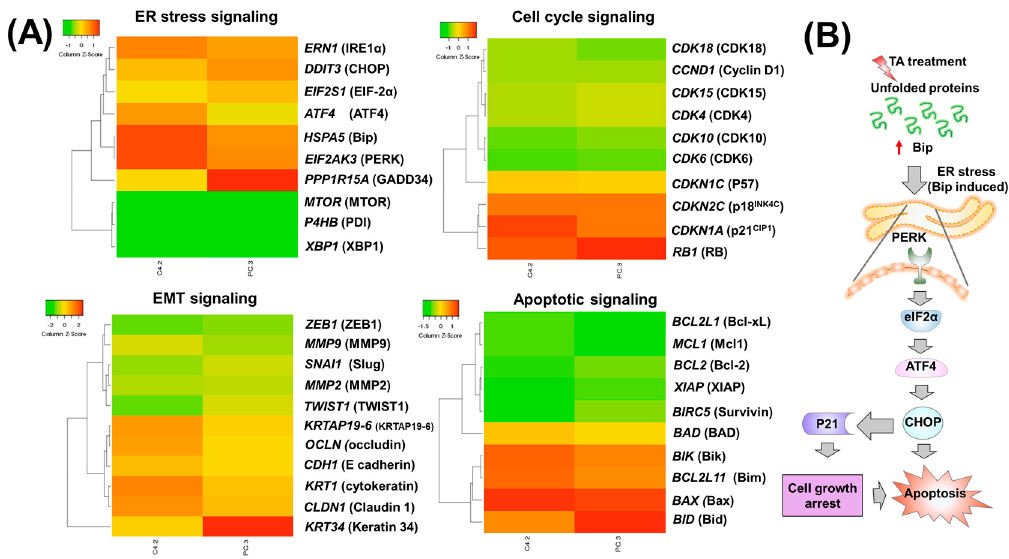
Figure 6. Molecular mechanism of TA in promoting unfolded protein response mediated ER stress and induced apoptosis in prostate cancer cells. ( A ) Heat map of differentially regulated genes in the ER Stress/EMT/Cell cycle regulatory/apoptosis signaling proteins in C4-2 and PC-3 prostate cancer cells; ( B ) Schematic illustration of TA-induced ER stress mediated apoptosis.